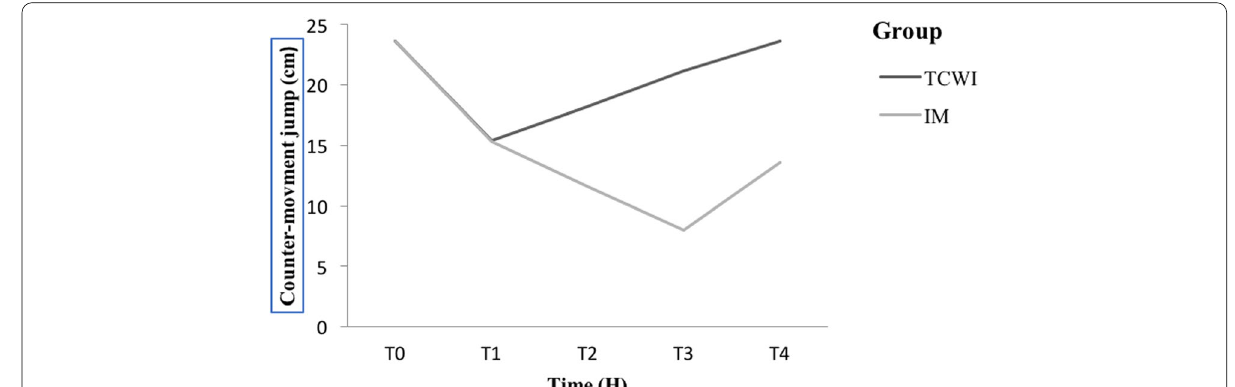
Fig. 3 Variation of countermovement jump’s height between groups at different timelines